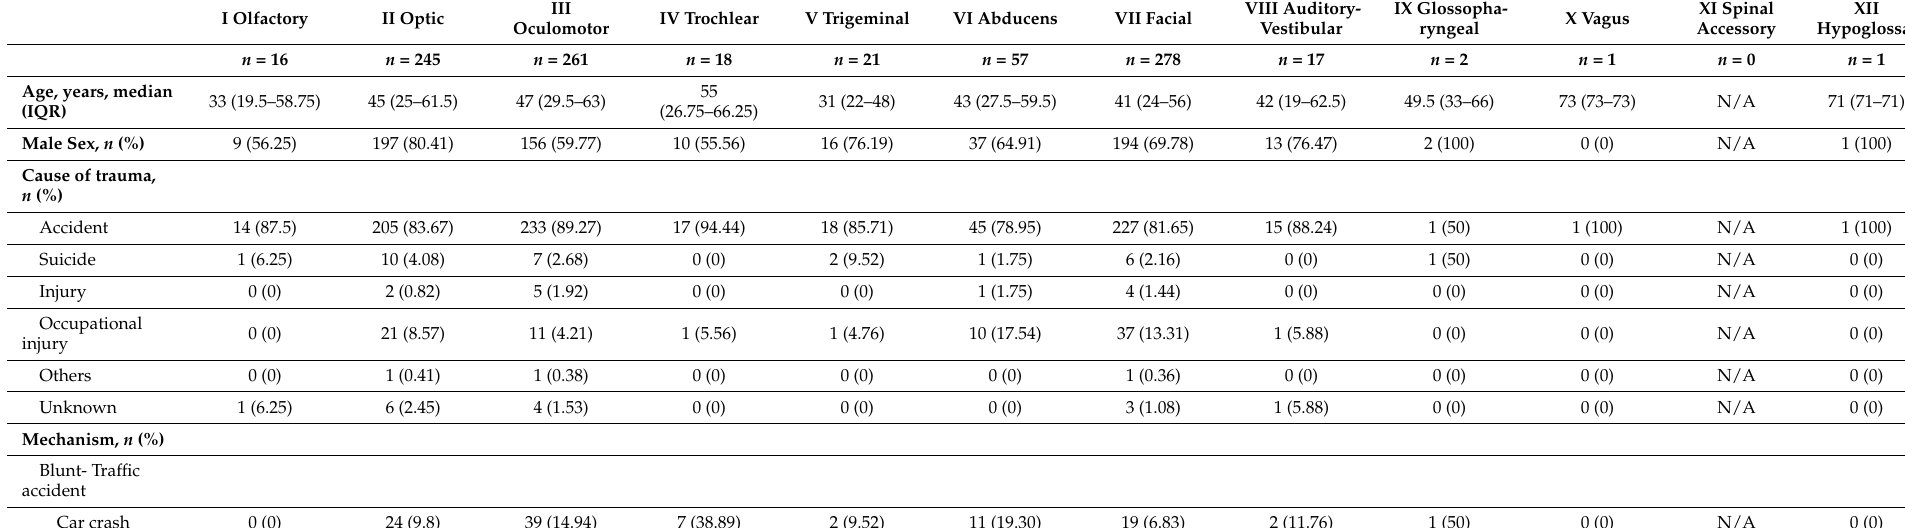
Table 3. Characteristics of trauma patients with cranial nerve